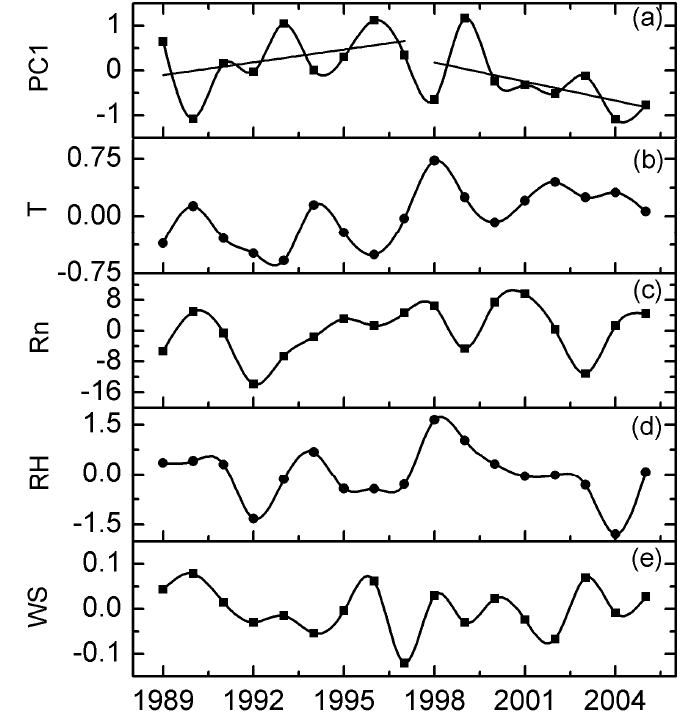
Figure 10. The evolution of PC1 ( a ) and temperature ( b ), net radiation ( c ), relative humidity ( d ), and wind speed ( e ) from 1989 to 2005 in the energy-control region. The black line segments are the lines fitted to the ET anomalies before and after 1998.